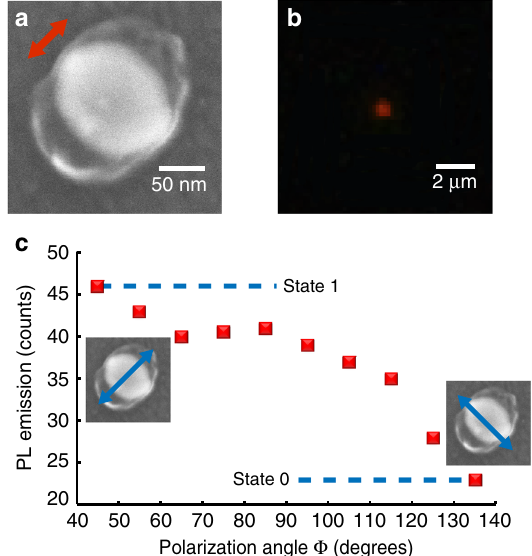
Fig. 5 Photoluminescence measurements on single hybrid nano-emitters. Hybrid nanosystem based on a Au nanodisk and CdSe/CdS/Zn quantum dots embedded within the polymer nanometric lobes. The hybrid nanosystem is obtained by plasmonic 2-photon polymerization using 45° tilted linear polarization (red arrow). a SEM image of the nanosystem (raw image). b Far- fi eld PL image excitation at polarization angle ϕ = 45°, λ = 405 nm, linear polarization. c PL intensity as function of the angle of polarization ϕ , λ = 405 nm, linear polarization is represented as blue arrows.